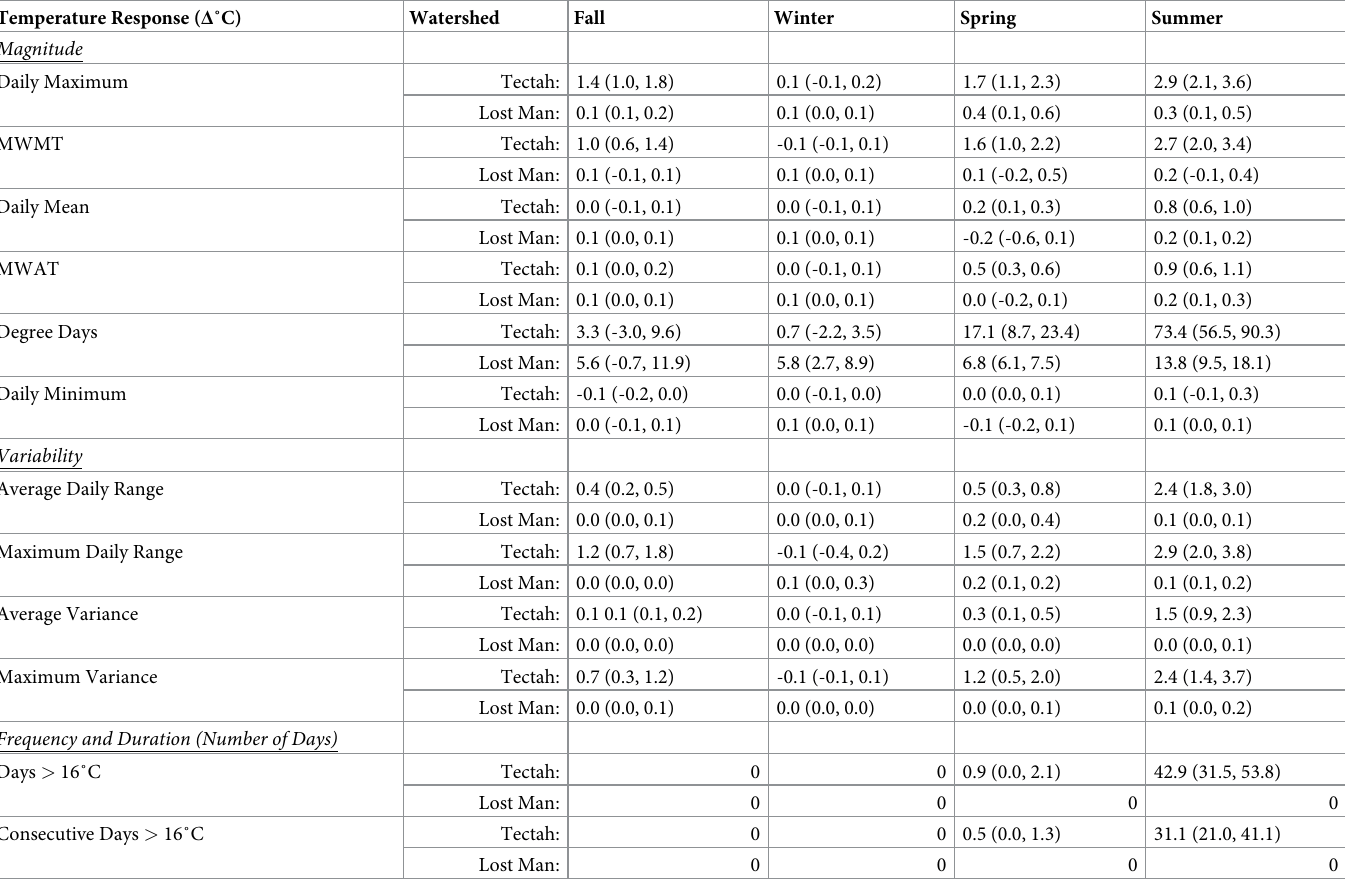
Table 2. Stream thermal regime responses in thinned